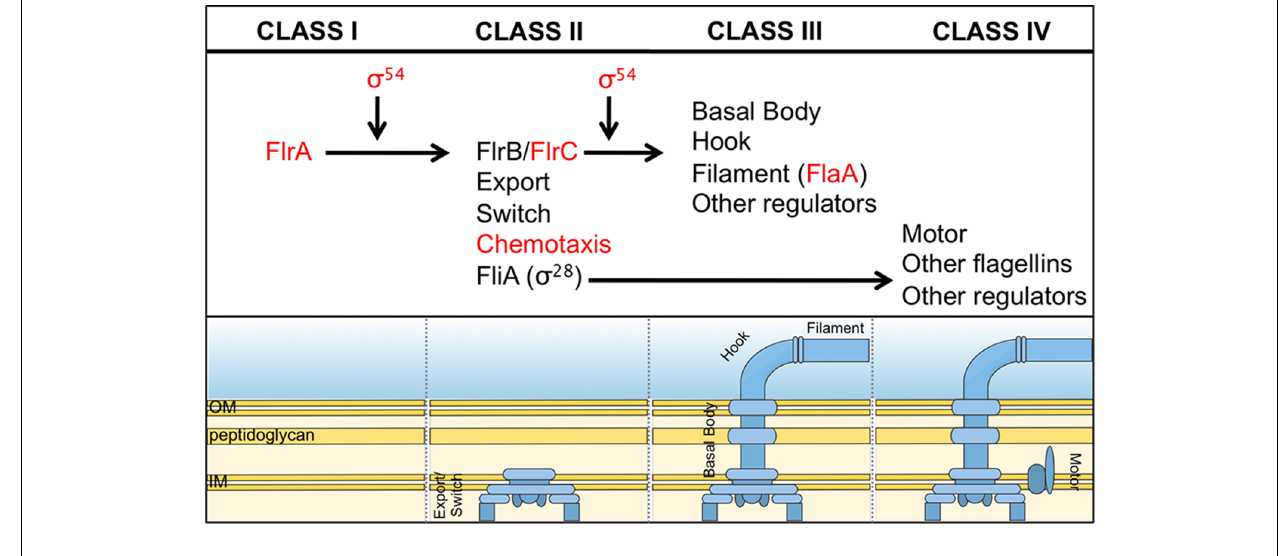
σ 28 (FliA). FlrB and FlrC control transcription of Class III genes necessary for synthesis of the distal basal body, hook, and filament, while σ 28 regulates transcription of Class IV genes involved in the production of motor proteins and other miscellaneous factors. Regulators in red indicate they are important for V. fischeri to colonize the squid (Millikan and Ruby, 2003, 2004; Hussa etal., 2007; Brennan etal.,